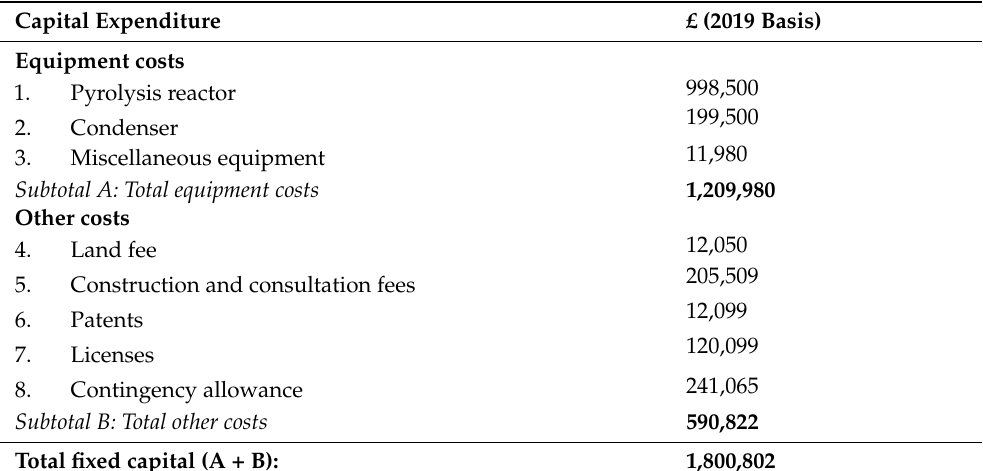
Table 3. Capital expenditure from HYSYS simulation for the conversion of HDPE to fuel via